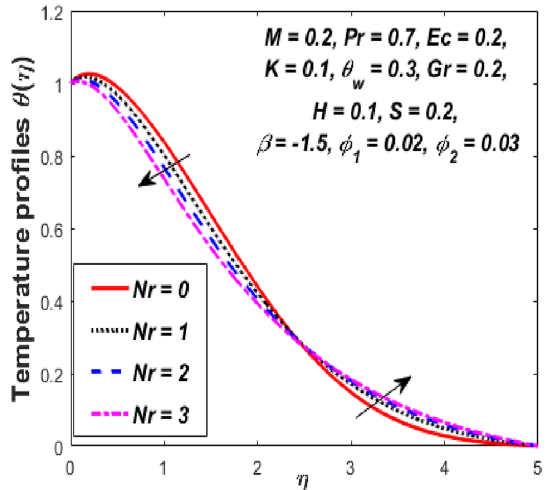
Figure 9. Influence of Nr on temperature θ(η) profile.